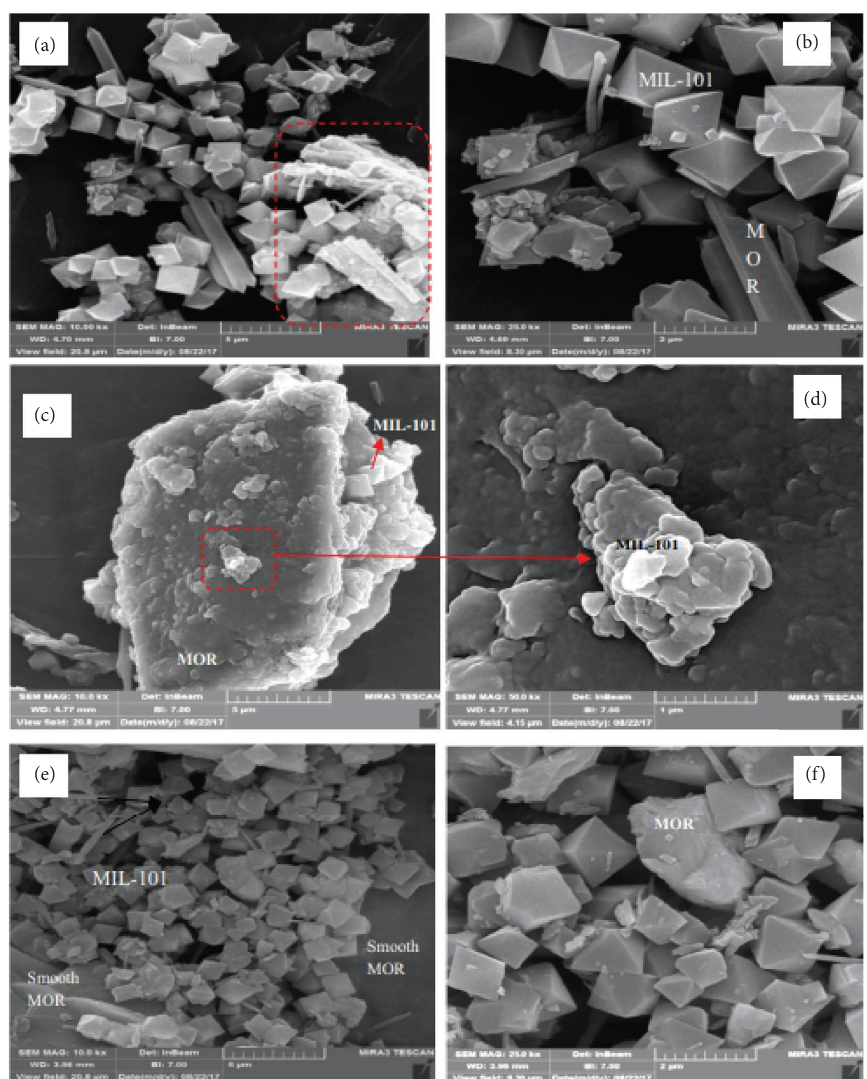
Figure 23: SEM Images of MOR@MIL-101 composites (a, b) synthesis methods MOR@MIL-101S, (c, d) MOR@MIL-101H, and (e, f) MOR@MIL-101R adopted from [1].